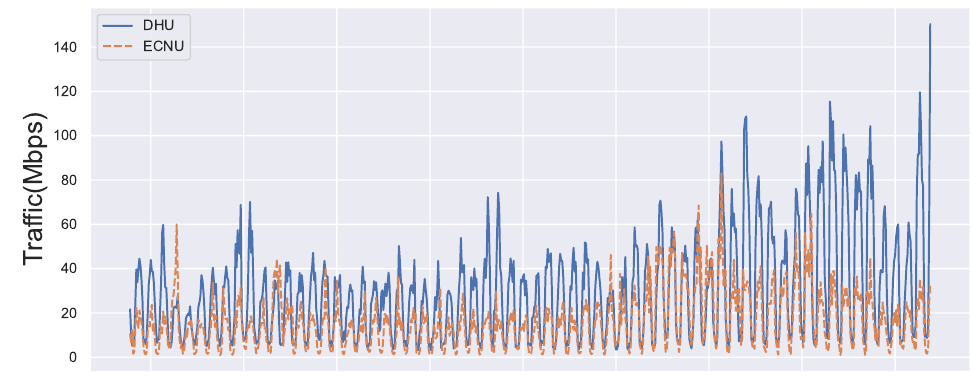
Figure 1. IPv6 downstream network traffic of DHU and ECNU.